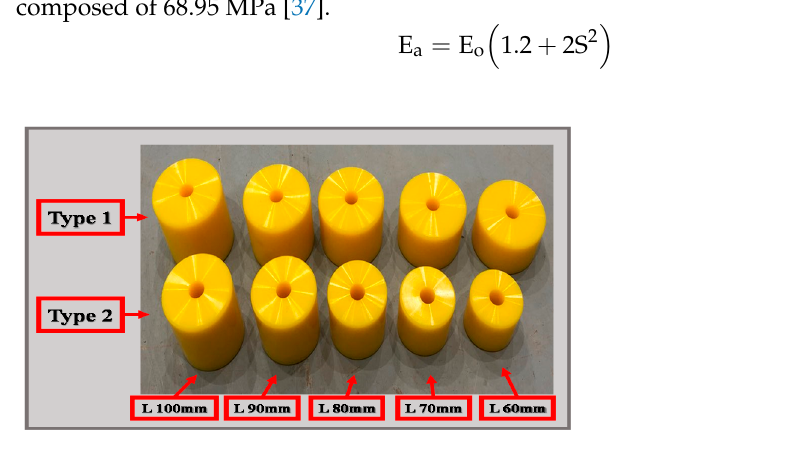
Figure 2. Two types of experimental specimens. Table 1. Properties of experimental specimens.